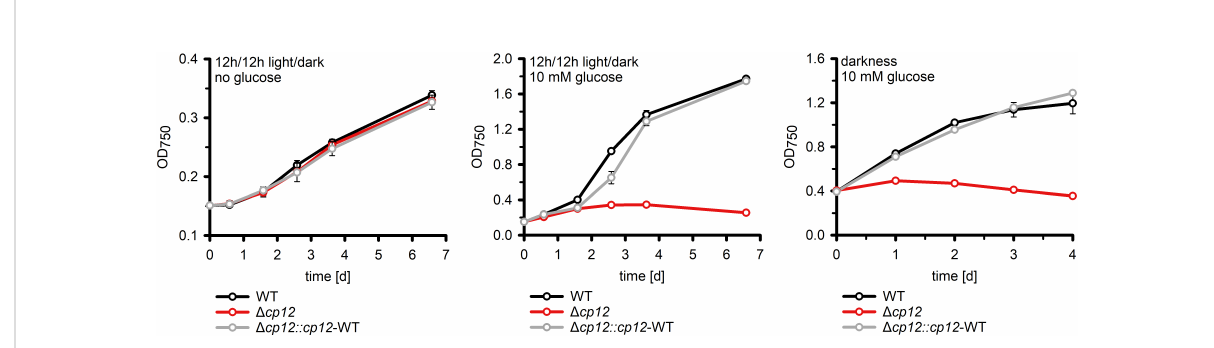
FIGURE 3 Growth of different strains in the absence and presence of glucose. The increase of optical density at 750 nm (OD 750 ) as proxy of biomass was compared in cultures of the Synechocystis wild type (WT), the mutant D cp12 , and the complementation strain D cp12::cp12 -WT. Shown are mean values and standard deviations from three independent cultivations.